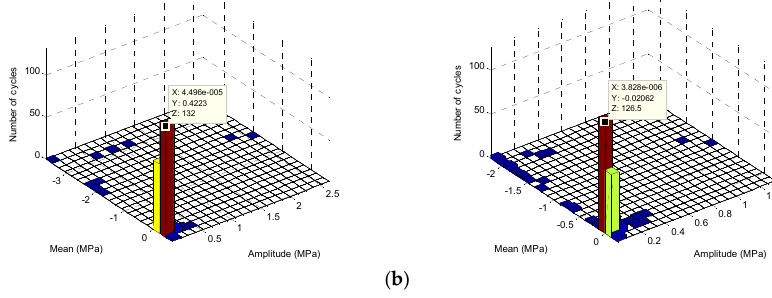
Figure 12. Rain-flow matrix of mid-span stress ( a ) 360 km/h; ( b ) 406 km/h.